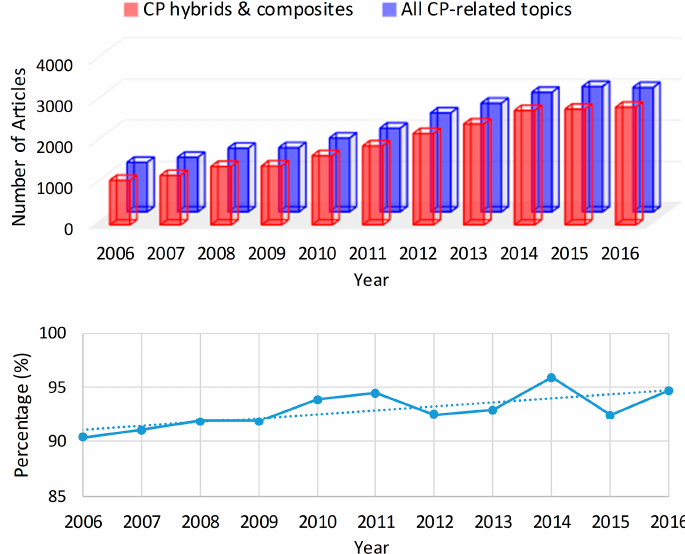
Figure 1. The proportion of articles published on hybrids/composites in the body of CP-related research over the last decade. Data from the ISI Web of Knowledge database.